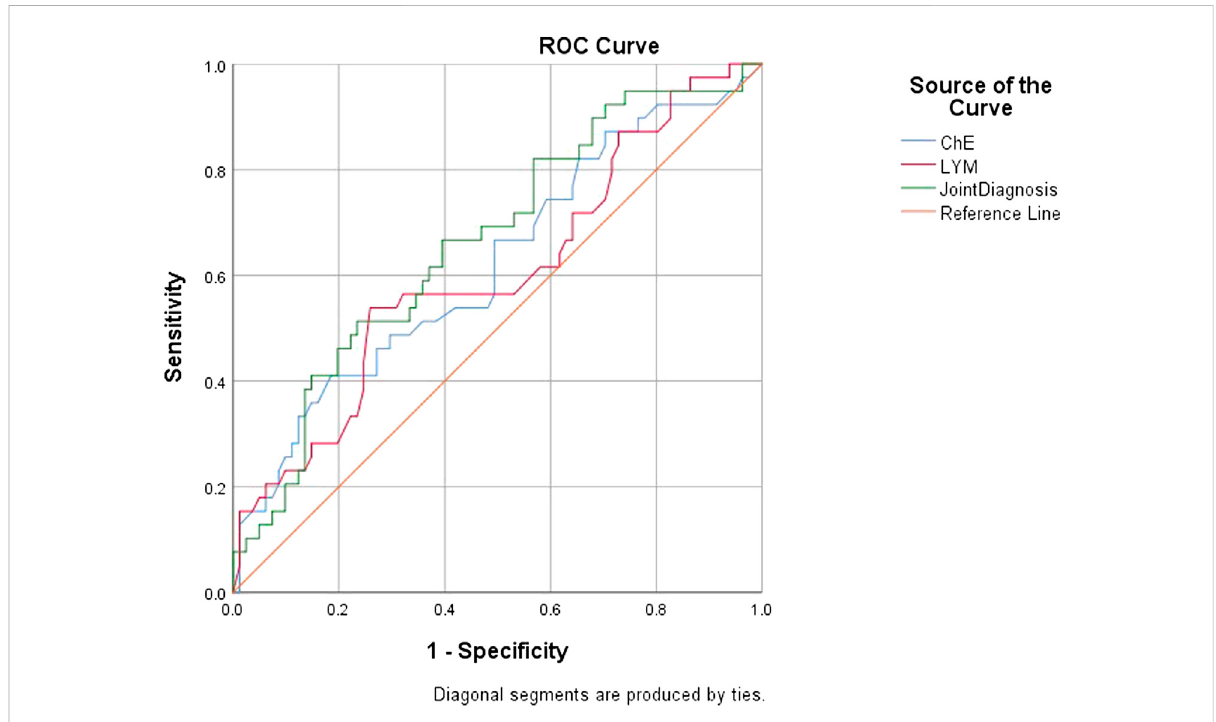
FIGURE 2 ROC curves of prognostic-related in fl uences of